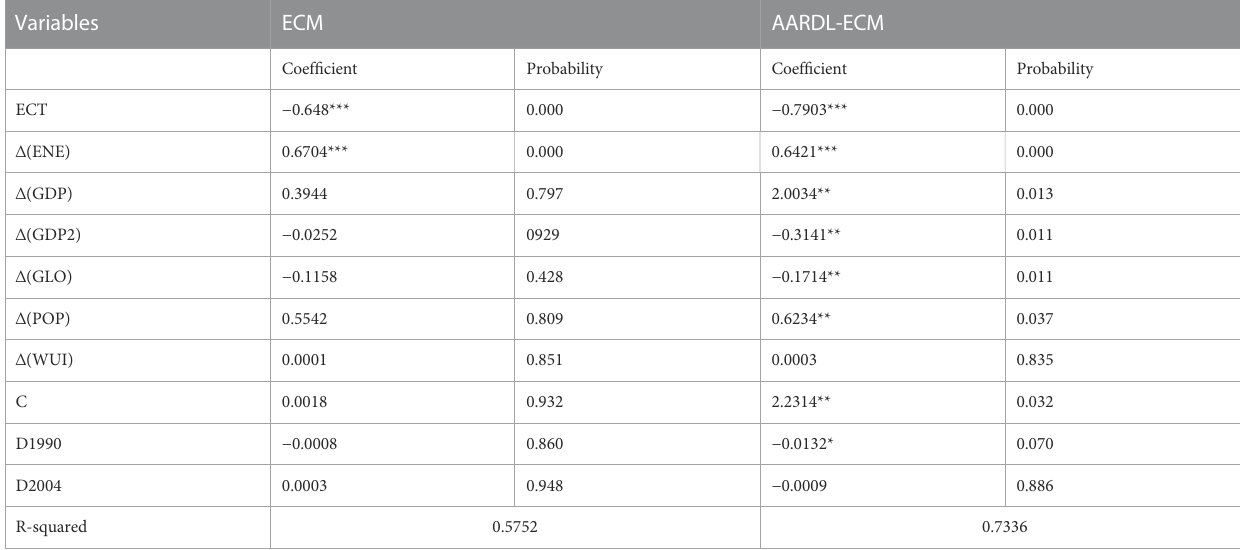
TABLE 4 ECM model for short-run estimation results.